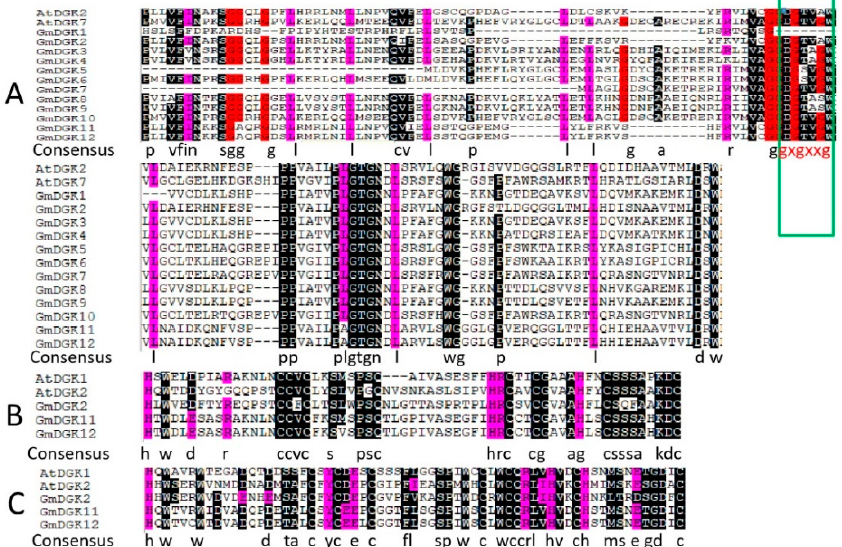
Figure 2. Multiple alignments of DGK catalytic (DGKc) domain ( A ), diacylglycerol/phorbol ester (DAG/PE)-binding domain C1 ( B ), and DAG/PE-binding domain 2 ( C ) in Glycine max and Arabidopsis thaliana.